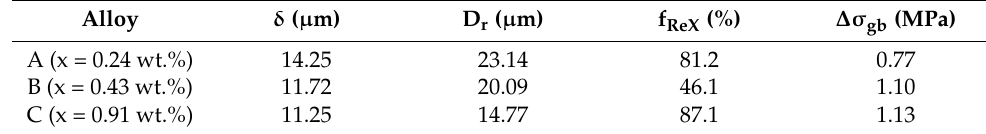
Table 5. Strength of grain boundaries of Al-5Zn-2.6Mg-xCu alloy in Nes model. Alloy δ ( µ m) D r ( µ m) f ReX (%) ∆ σ gb (MPa) A (x = 0.24 wt.%)